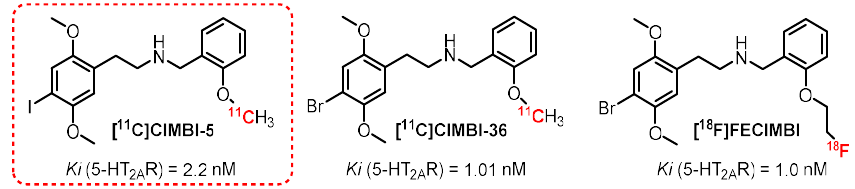
Figure 8. CIMBI-5 analogues as 5-HT 2A R radiotracers.